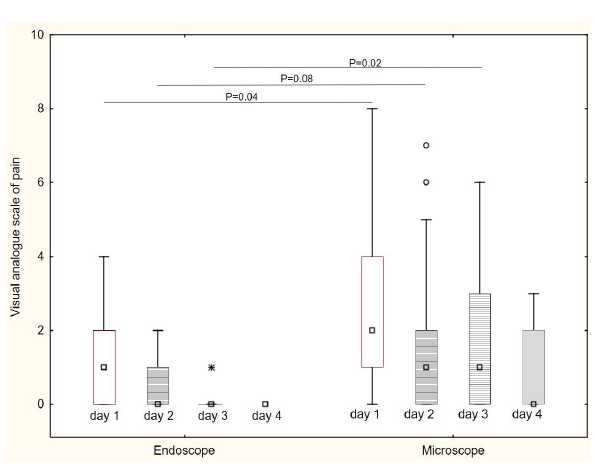
Fig. 1. A comparison of visual analogue scale of pain intensity after endoscopic and microscopic ear procedures in cholestea- toma group.